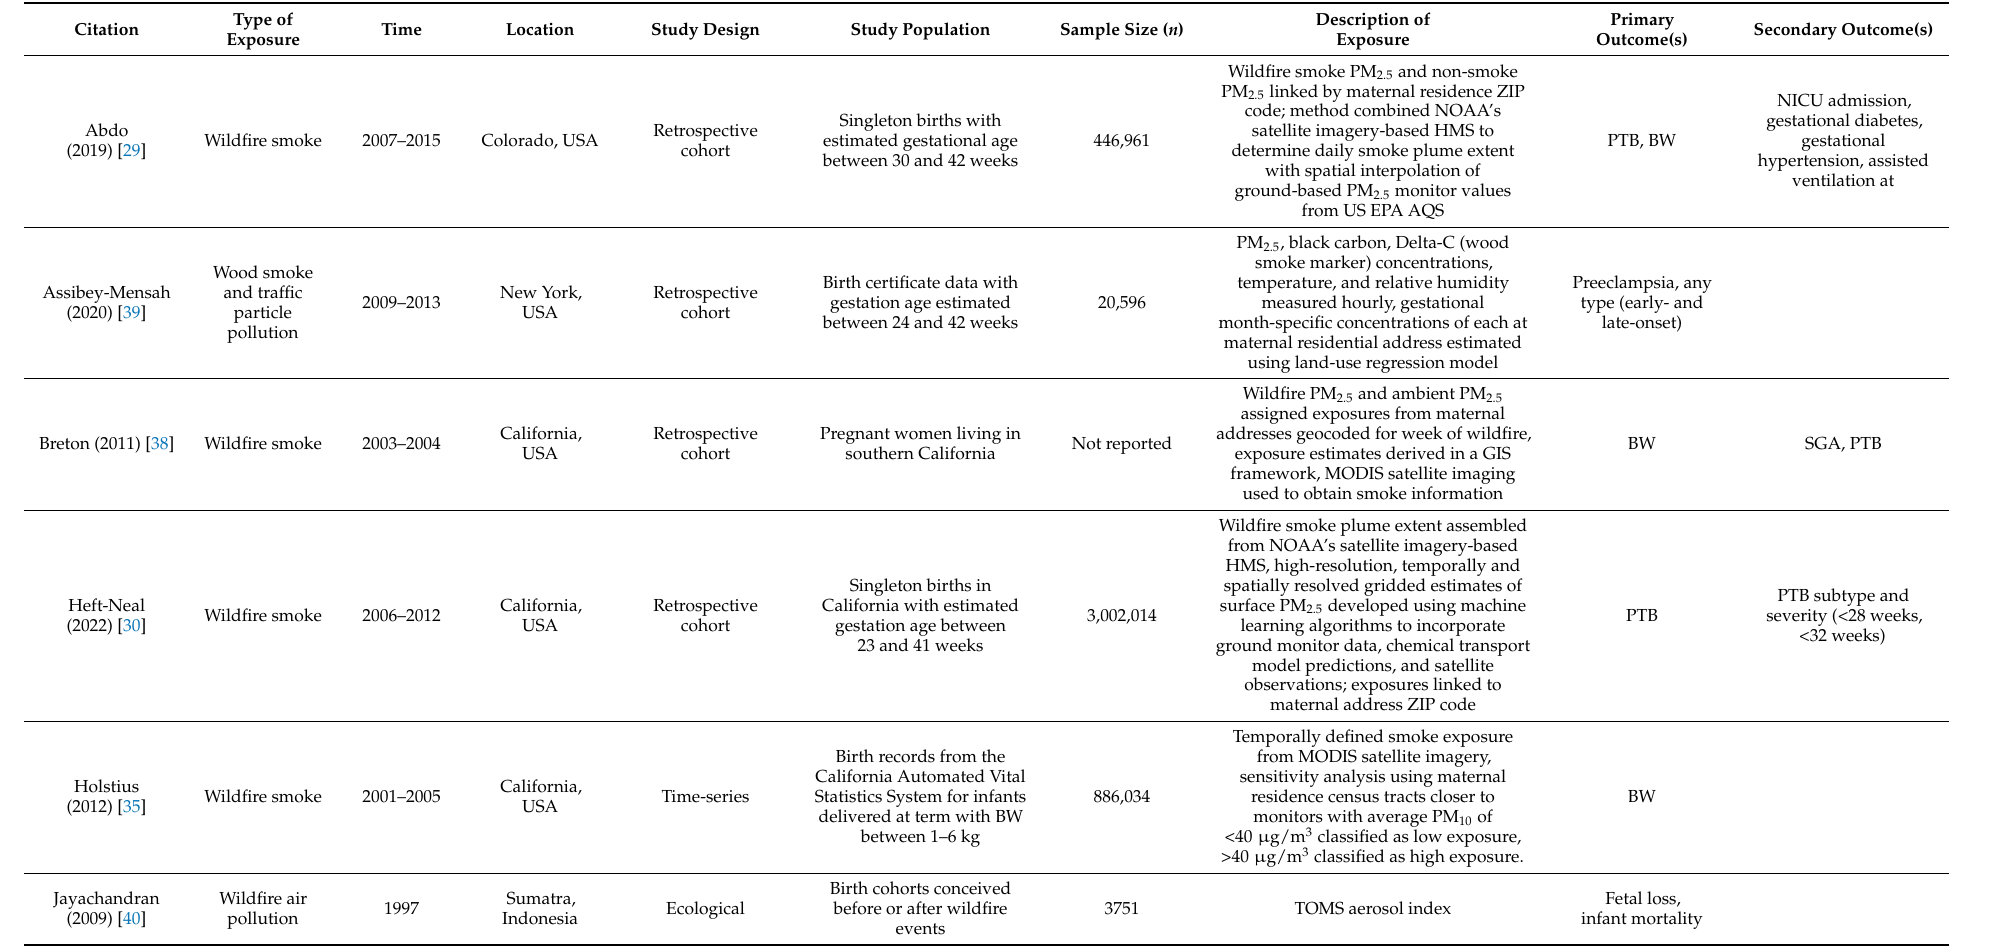
Table 1. Summary of population-based studies in pregnancy included in our review. For each study, we provide the citation, time frame, location, study design, study population, and sample size. We also provide a description of the exposure. Finally, we indicated the primary and secondary outcomes observed, if applicable. Citations are listed in alphabetical